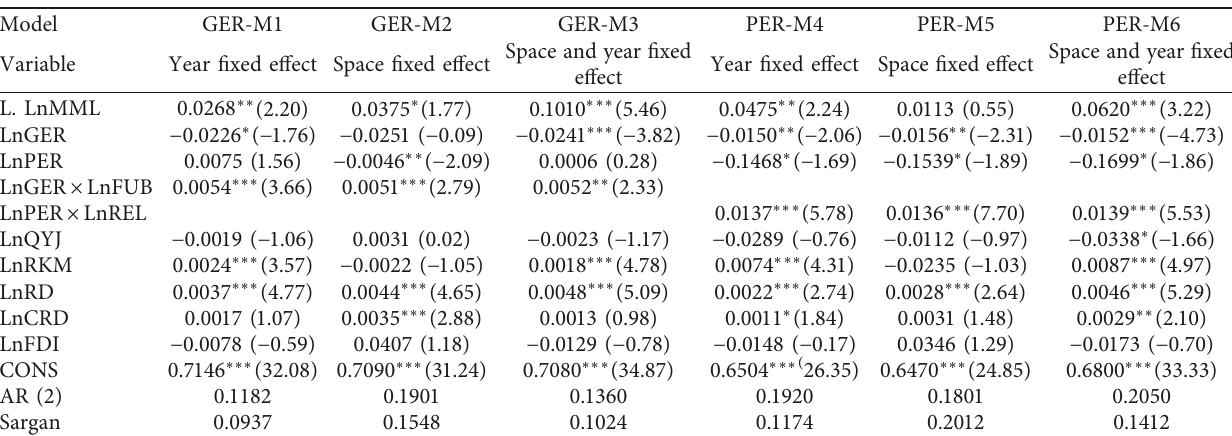
Table 4: Regression results of nonlinear effect model (threshold variable: FUB and